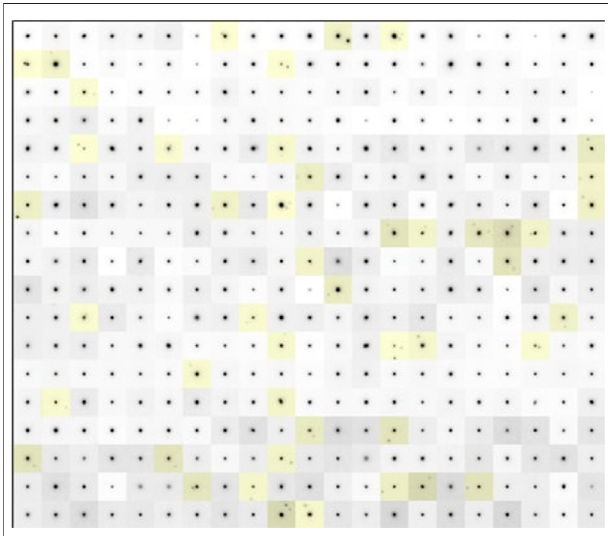
FIGURE 2 | Robo-AO centered cutout images of Kepler planetary candidate host stars. Systems with discovered nearby stars are highlighted. Shown are ∼ 10% of the targets from the Robo-AO survey of KOIs, the largest adaptive optics survey of exoplanet hosts yet performed. Results from this survey have been used to validate over a thousand planets.